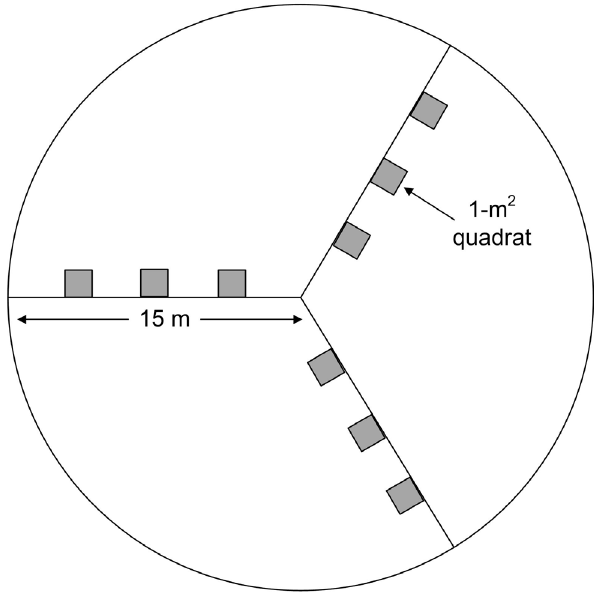
Figure 2. Sampling design within each plot (Modified from NAWMA field data collection scheme (Stohlgren et al., 2005)).